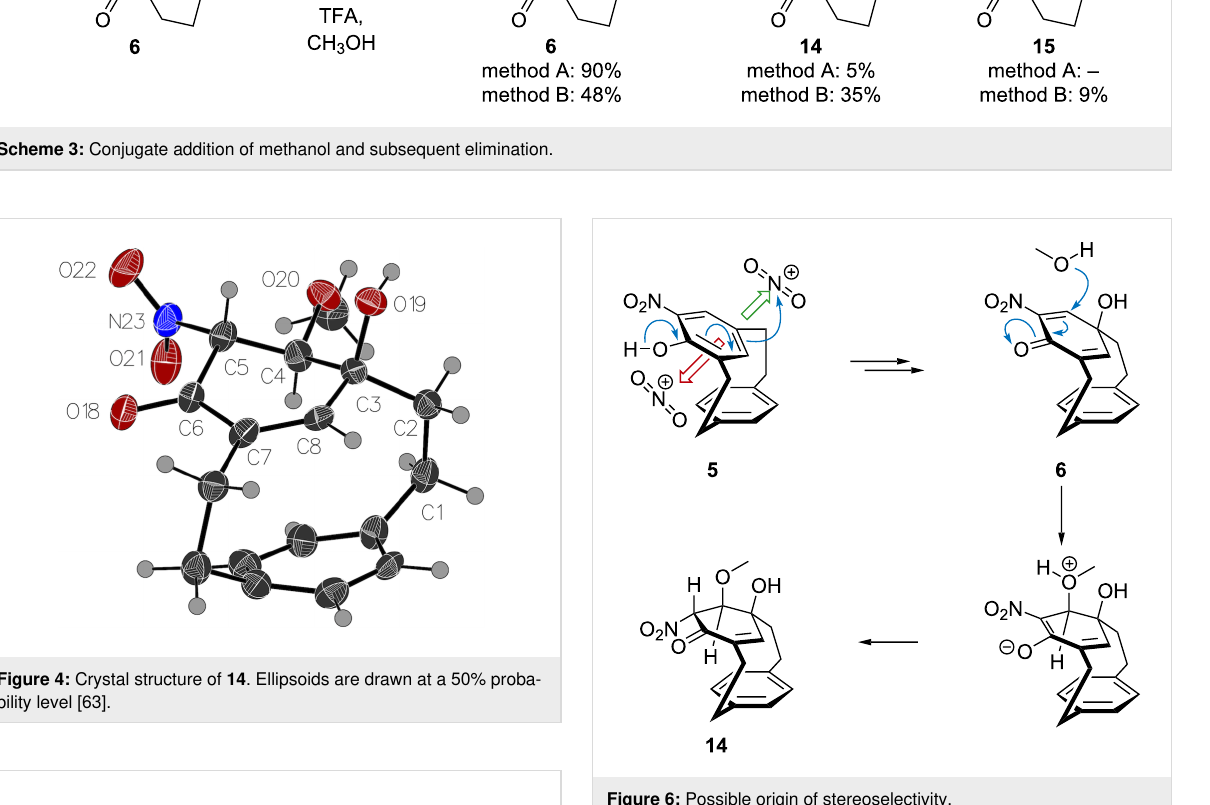
Figure 6: Possible origin of